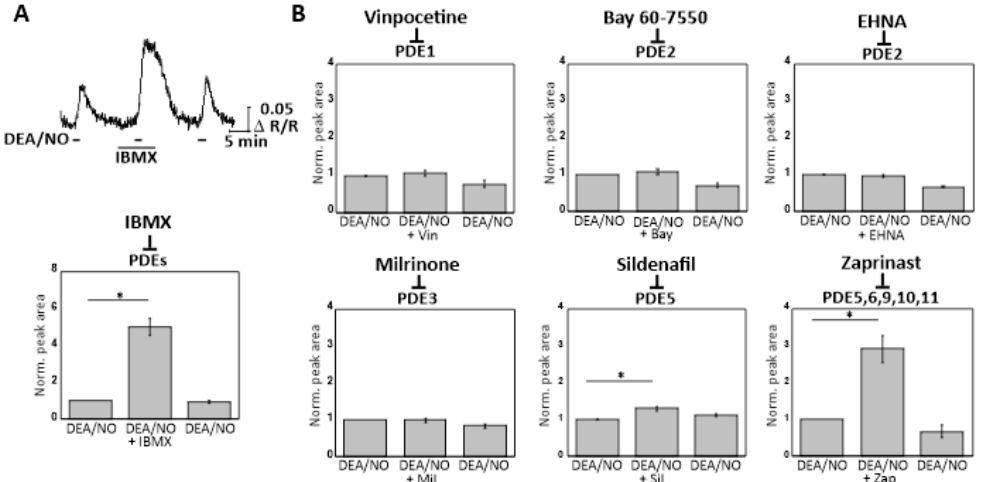
Figure 5. Real-time cGMP imaging in CGNs reveals degradation of cGMP by Zaprinast-sensitive PDEs. ( A ) cGi500-expressing CGNs isolated from R26-CAG-cGi500(L1) mice were stimulated three times with DEA/NO (50 nM), first with DEA/NO alone, then in the presence of IBMX (100 µ M), and finally again with DEA/NO alone. The bar graph shows the statistical evaluation of DEA/NO-induced cGMP peak areas before (first peak), during (second peak), and after (third peak) incubation with IBMX. Peak areas were normalized to the first peak of each experiment. Data are presented as mean ± SEM; * p < 0.05 first versus second peak ( n = 6 cells measured on three coverslips obtained from three CGN cultures). ( B ) As described for ( A ), CGNs were superfused with DEA/NO (50 nM) in the absence and presence of indicated PDE inhibitors. The following PDE inhibitors were tested: 5 µ M Vinpocetine (Vin); 10 nM Bay 60-7550 (Bay); 10 µ M EHNA; 10 µ M Milrinone (Mil); 20 µ M Sildenafil (Sil); 20 µ M Zaprinast (Zap). Data are presented as mean ± SEM; * p < 0.05 first versus second peak ( n = 6–12 cells per condition; cells were measured on two coverslips obtained from two CGN